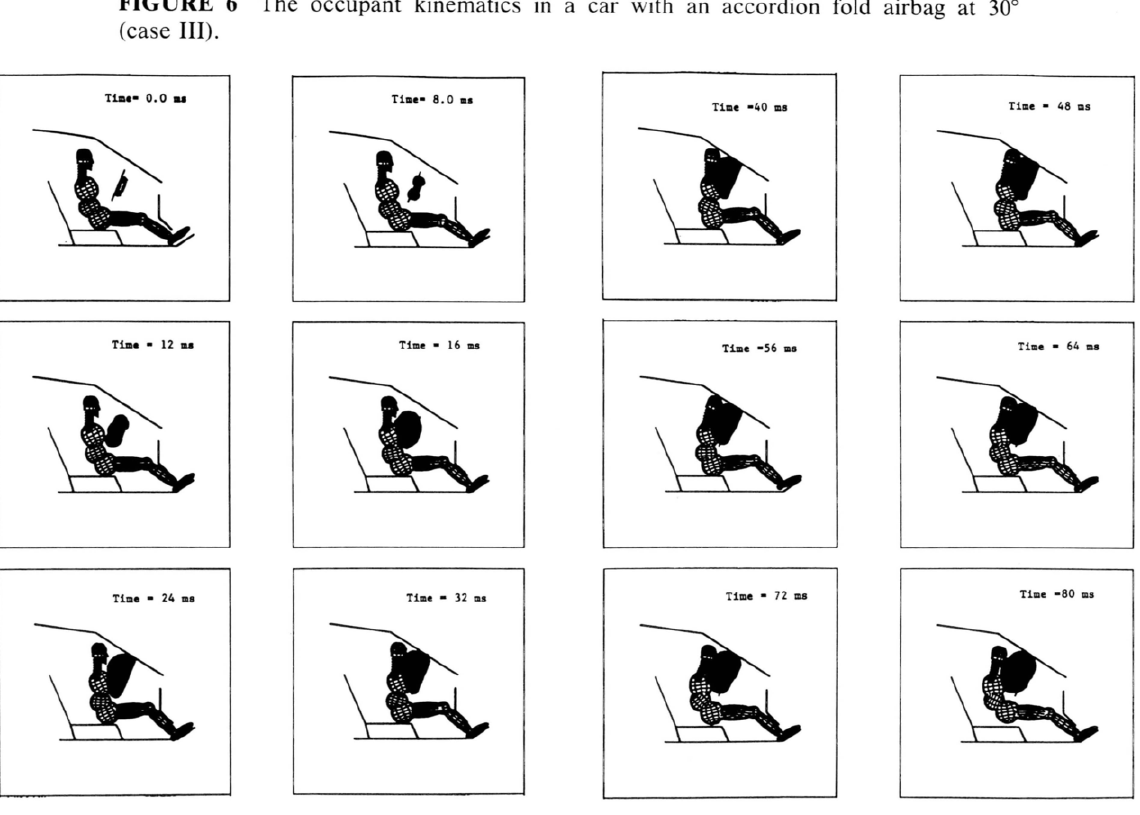
FIGURE 6 The occupant kinematics in a car with an accordion fold airbag at 30° (case III). T1ae- 0.0 ..